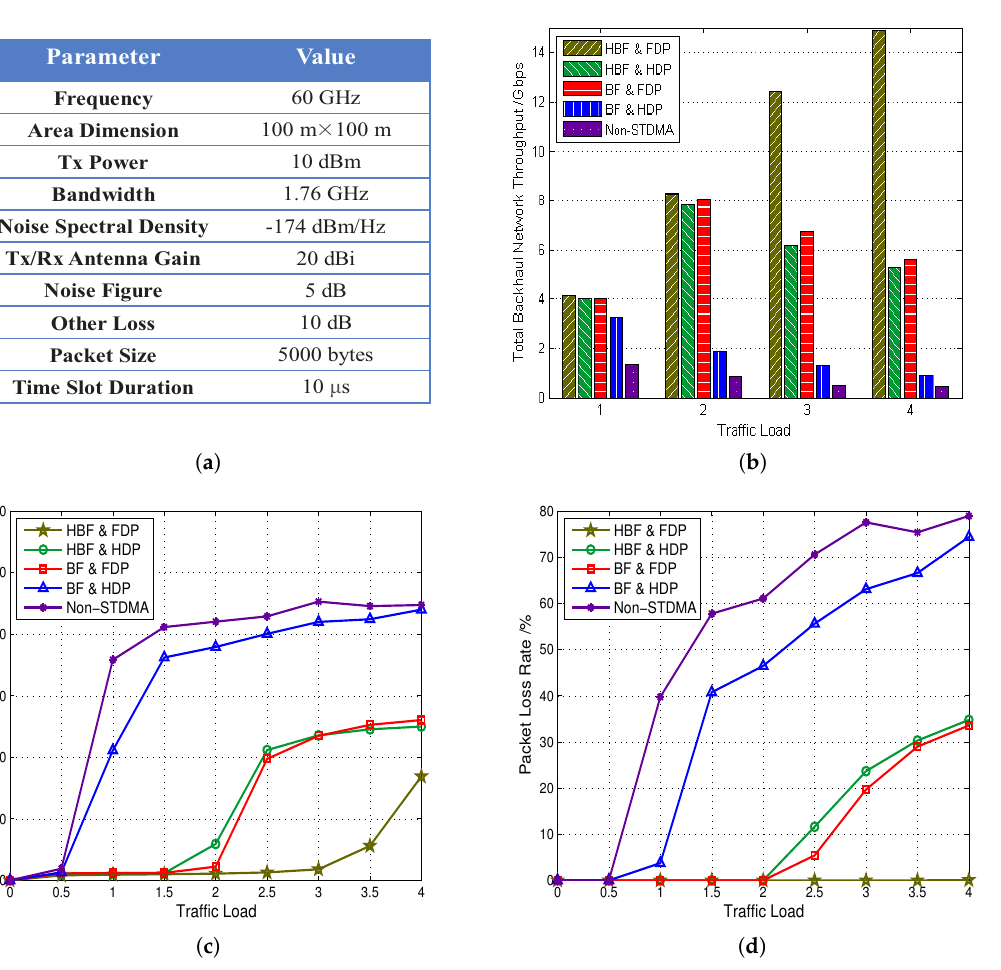
Figure 5. ( a ) Channel parameter settings and ( b – d ) the performance of the throughput, delay and packet loss rate of five schemes, respectively (HBF, BF, HDP and FDP refer to hybrid beamforming, analogue beamforming, half-duplex and full-duplex, respectively, while non-STDMA is the scheme that does not adopt spatial reuse at